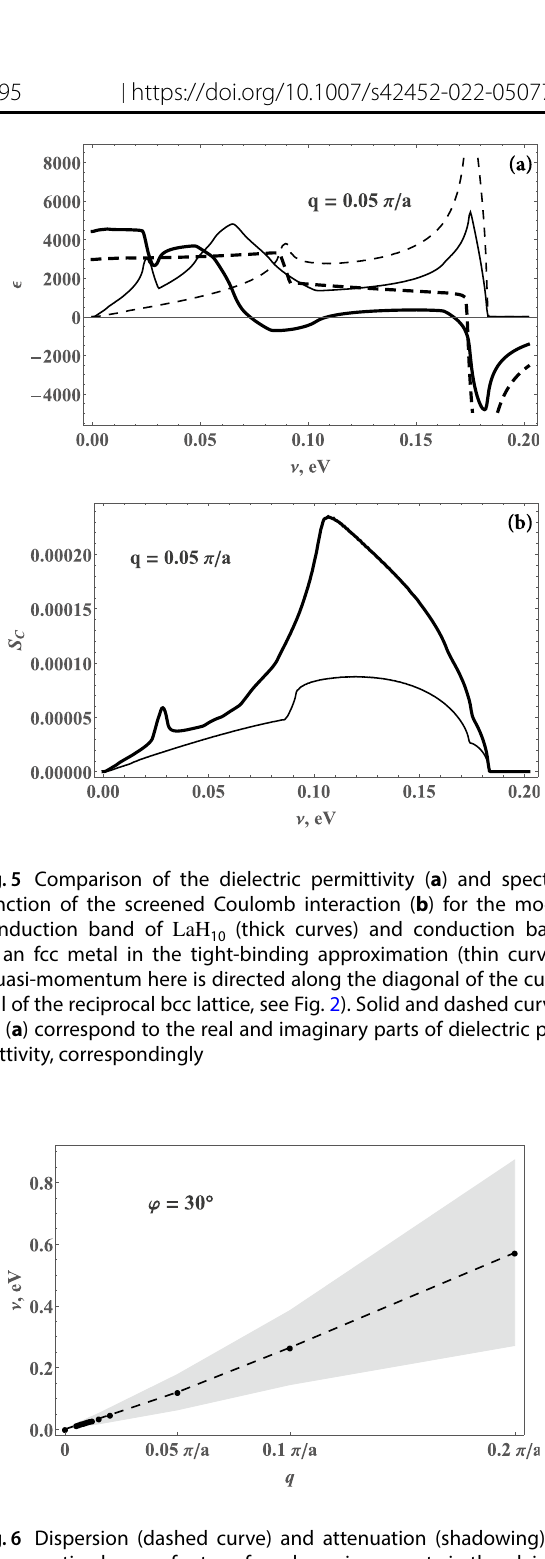
Fig. 6 Dispersion (dashed curve) and attenuation (shadowing) of the acoustic plasmon for transferred quasi-momenta in the plain of the hexagonal edge of the Brillouin zone. Dots represent calculated values, while dashed line is just a guide for the